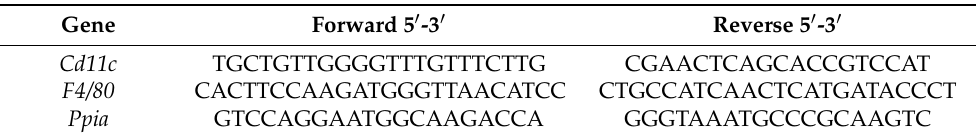
Table 2. Primer sequences for